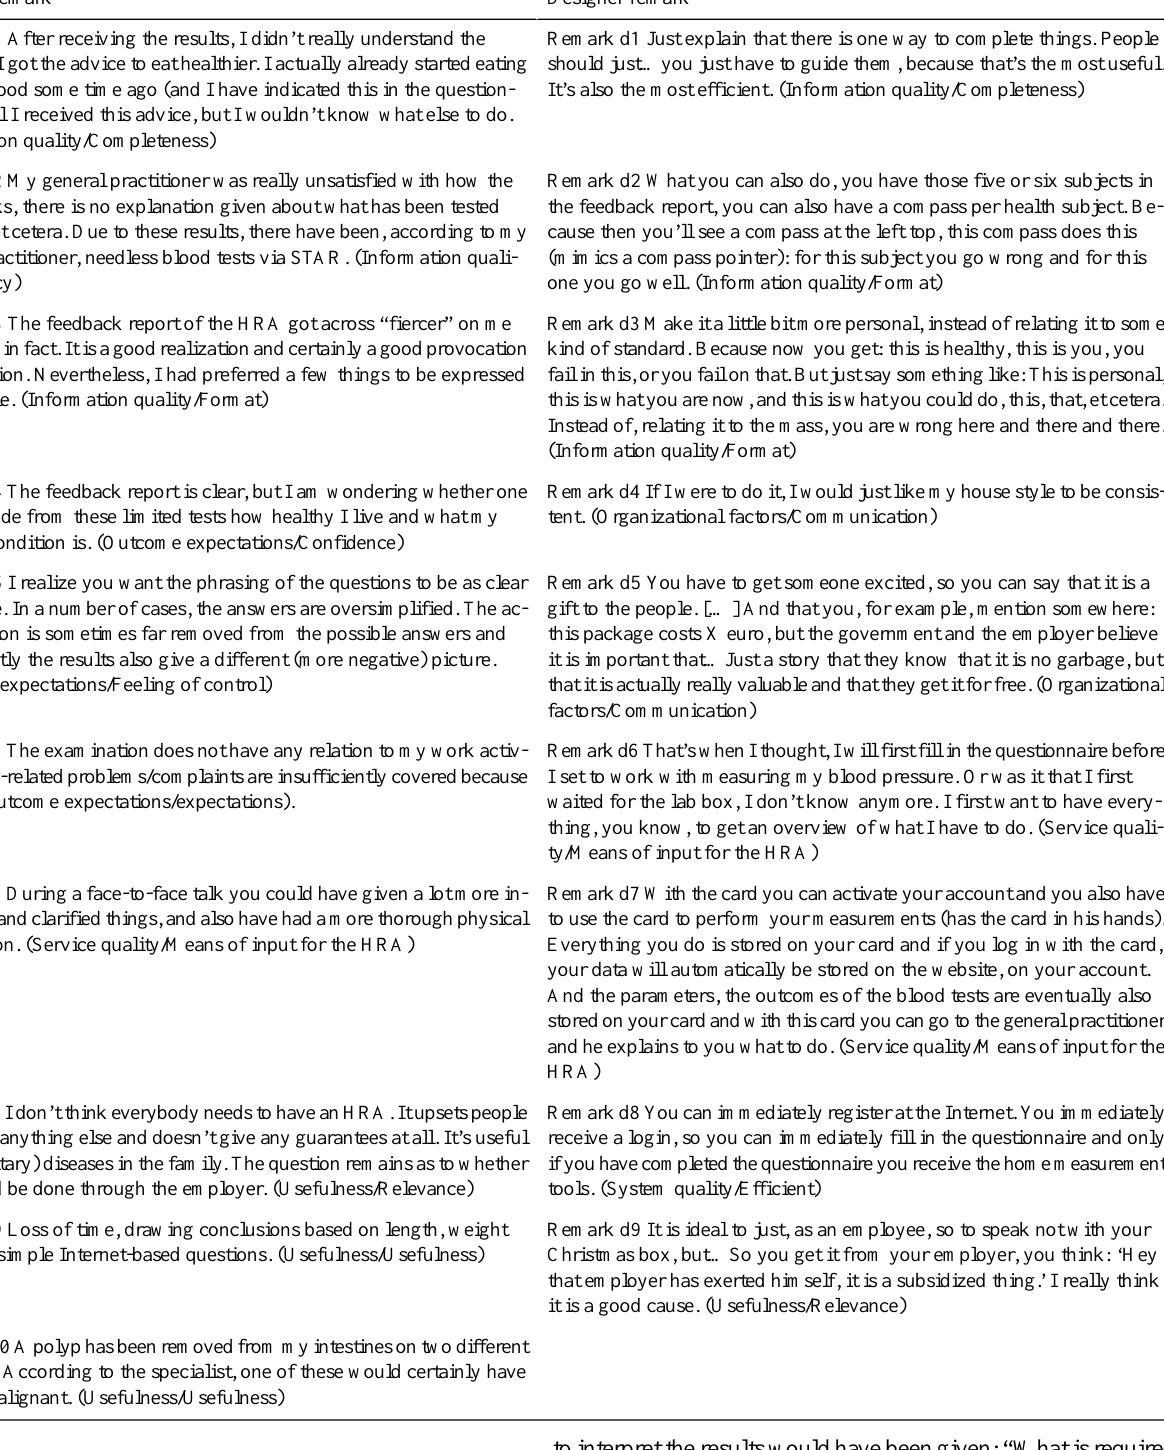
Designer remarkEnd-user